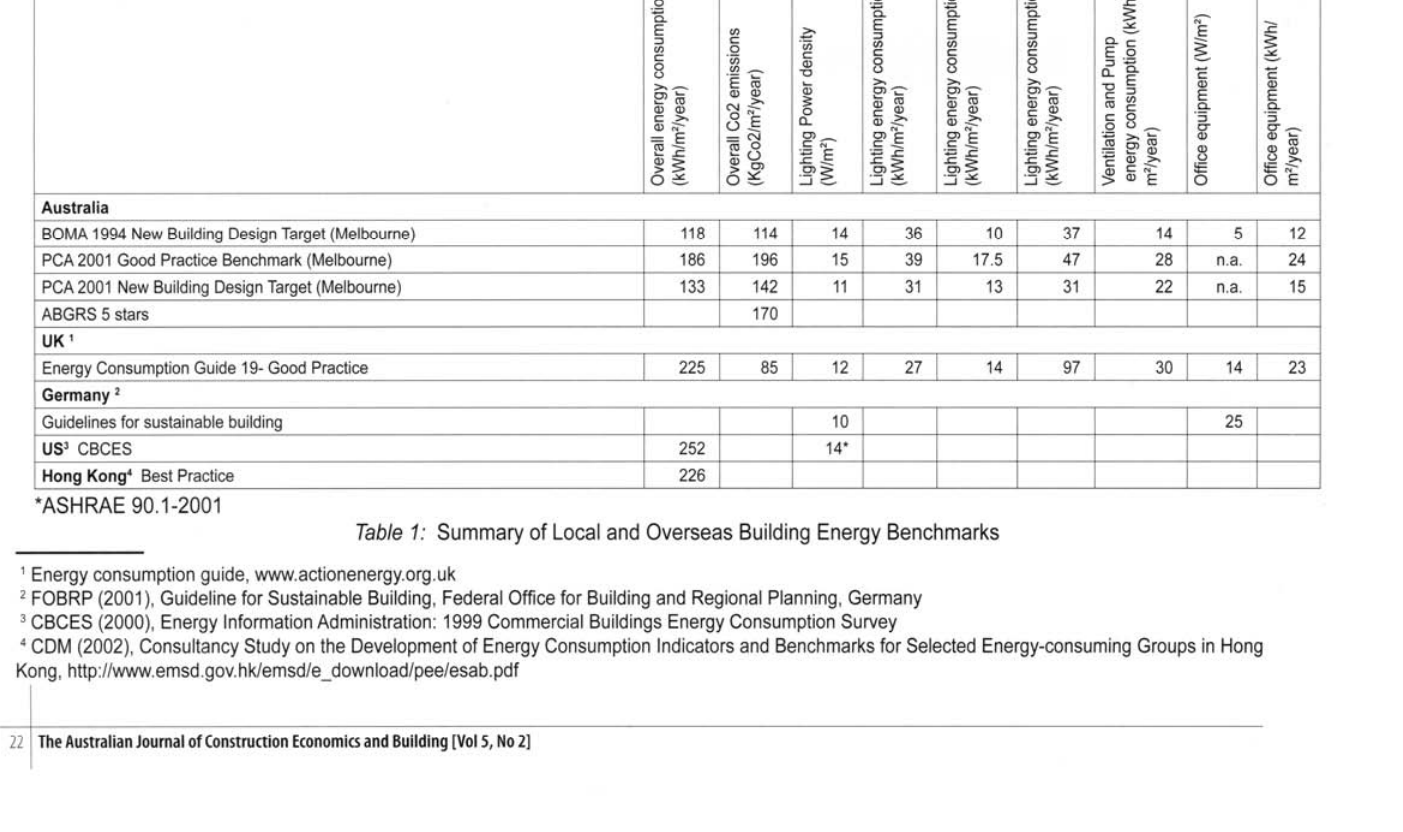
Table 1: Summary of Local and Overseas Building Energy